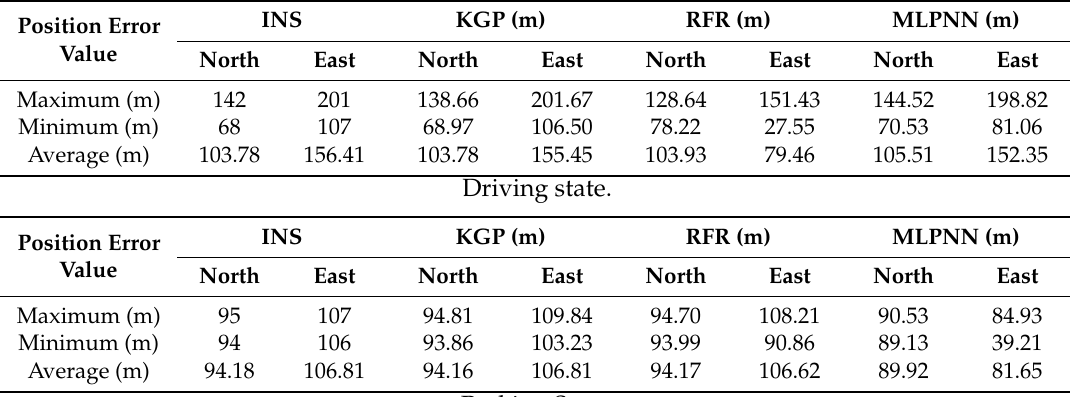
Figure 7. Prediction results of the combined test: ( a ) north position error and ( b ) east position error. Table 4. Comparing errors of the combined test in east-north